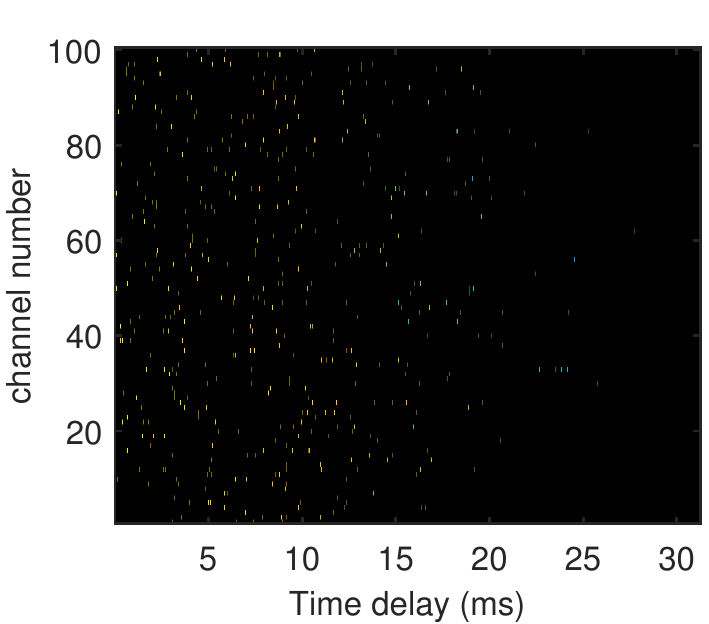
Figure 9. CIR of 100